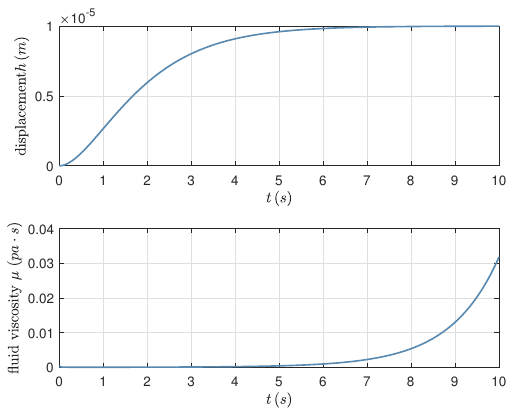
Figure 4. Feedback linearization control input and resulting tracking performance.